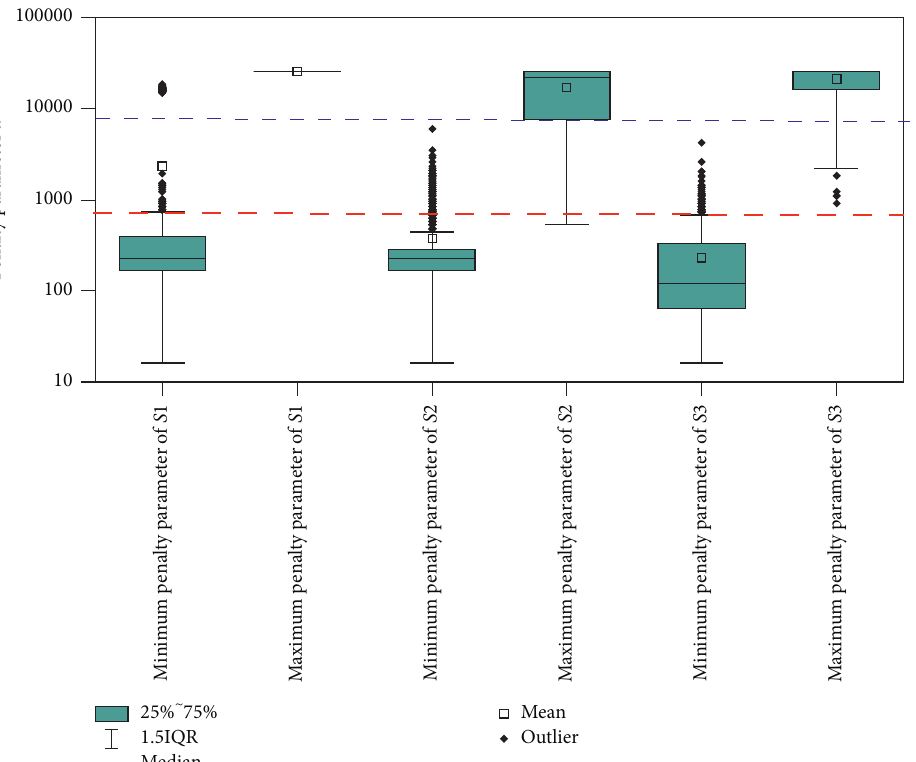
Figure 5: The box diagram of the penalty parameter α when the frequency error is less than